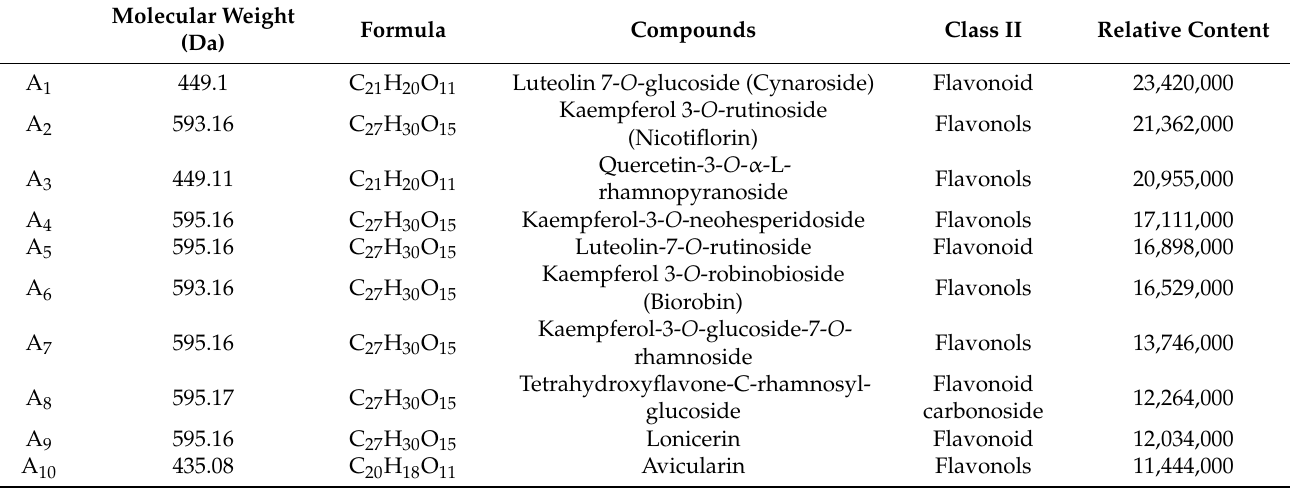
Table 1. The relative content of major flavonoid